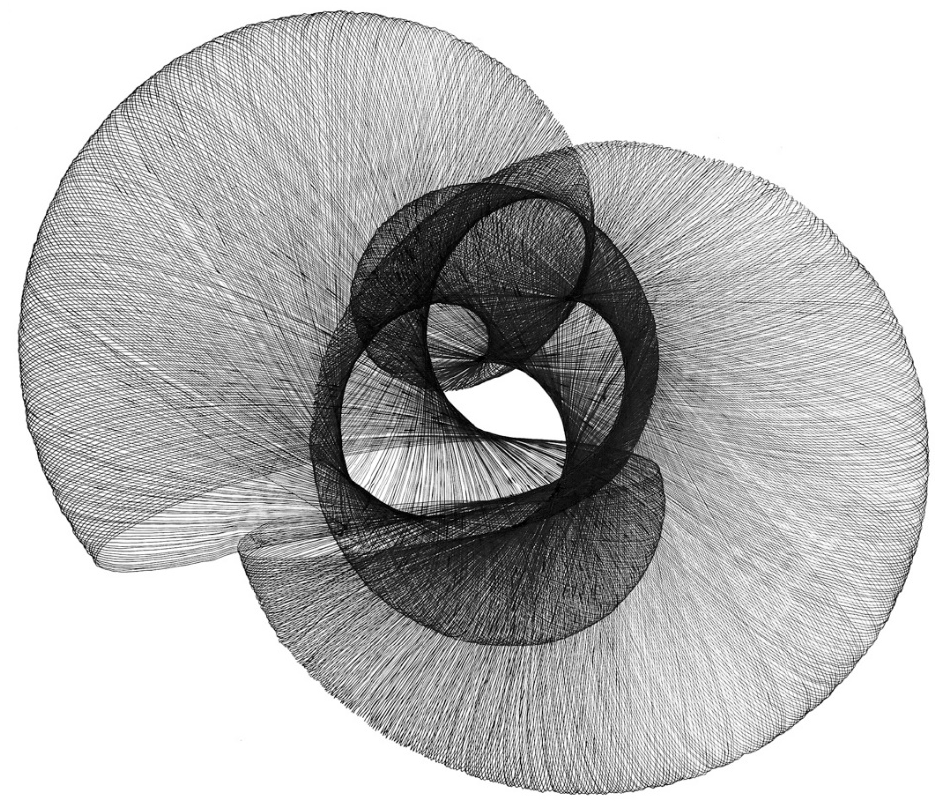
Figure 7. Primary HHM drawing with no pen lift.